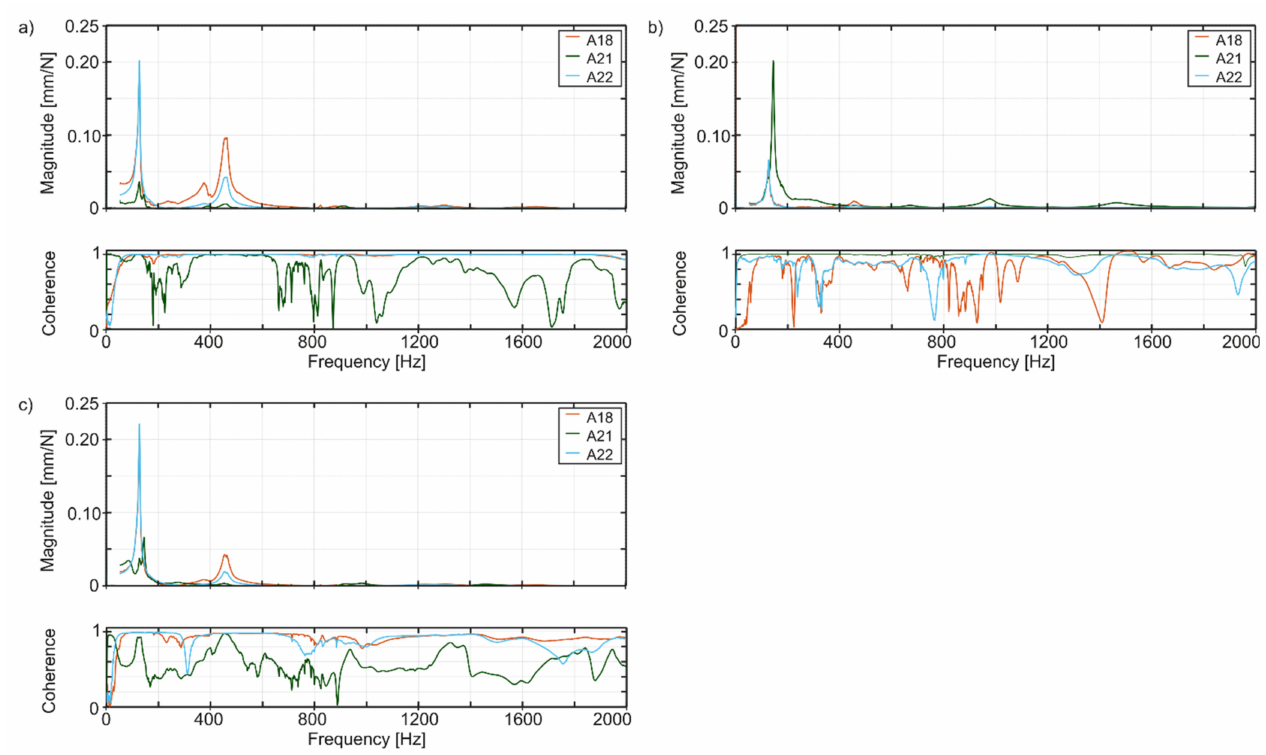
Figure 6. Exemplary force-displacement FRFs of the boring tool for excitation in the direction of sensor no. ( a ) A18, ( b ) A21, ( c )